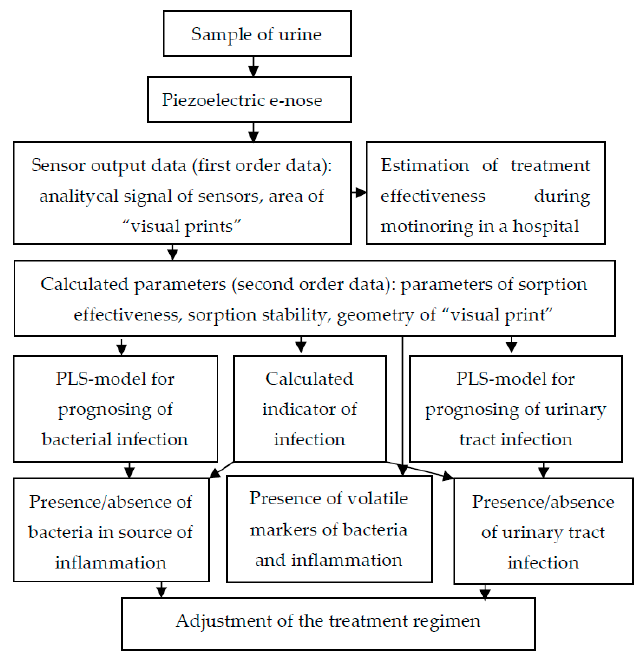
Figure 8. Scheme of application of piezoelectric “electronic nose” in urine analysis.